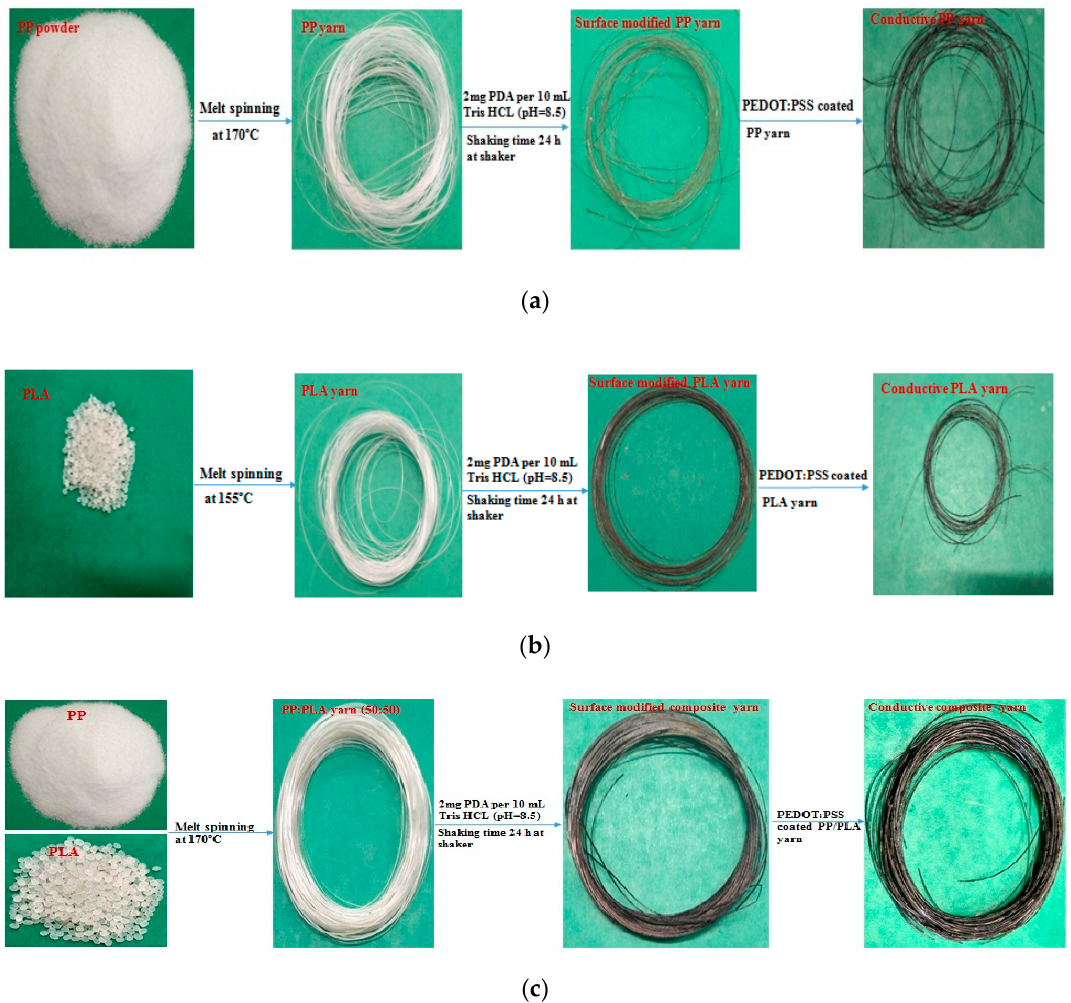
Figure 3. Schematic diagram of PEDOT:PSS coated conductive ( a ) PP, ( b ) PLA and ( c ) blend PP/PLA Figure3. SchematicdiagramofPEDOT:PSScoatedconductive( a )PP,( b )PLAand( c )blendPP / yarn.